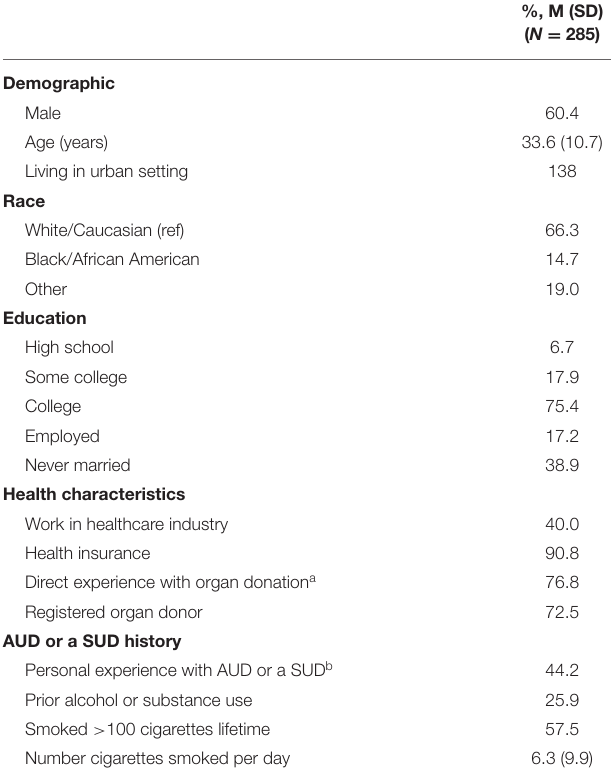
TABLE 1 | Respondent